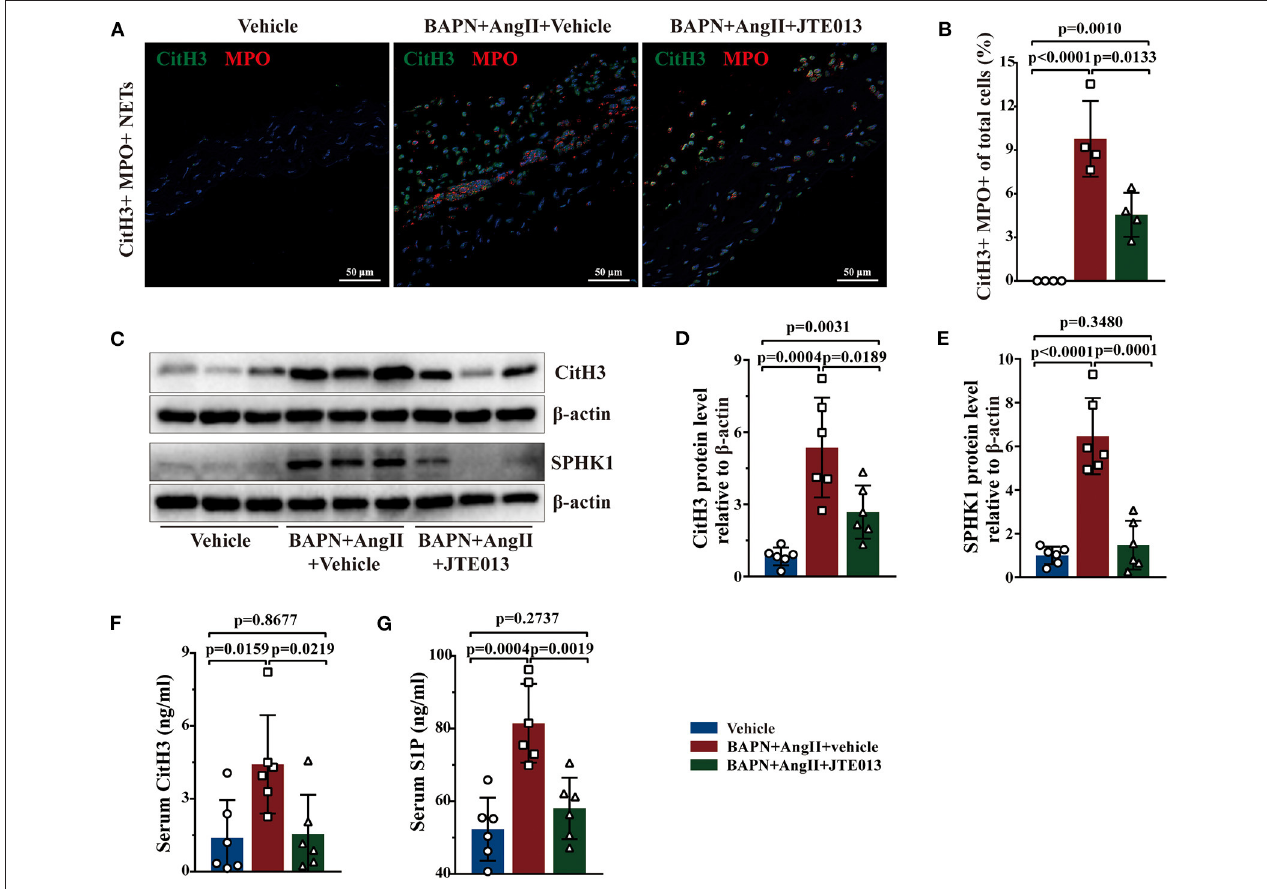
FIGURE 7 | Inhibition of S1PR2 by JTE013 reduced NETs accumulation. (A) Representative images of CitH3 + (green) MPO + (red) double-immunofluorescence staining NETs area in mouse TAD lesions from each group. (B) The JTE013 treatment diminished NETs density ( n = 4). (C–E) Representative immunoblot and the corresponding analysis of mouse CitH3 and SPHK1 in each group ( n = 6). (F,G) JTE013 treatment reduced serum CitH3 and S1P levels ( n = 6). Scale: 50 µ m. Data are expressed as means ± SD. CitH3, a specific marker of NETs; MPO, a marker for neutrophil